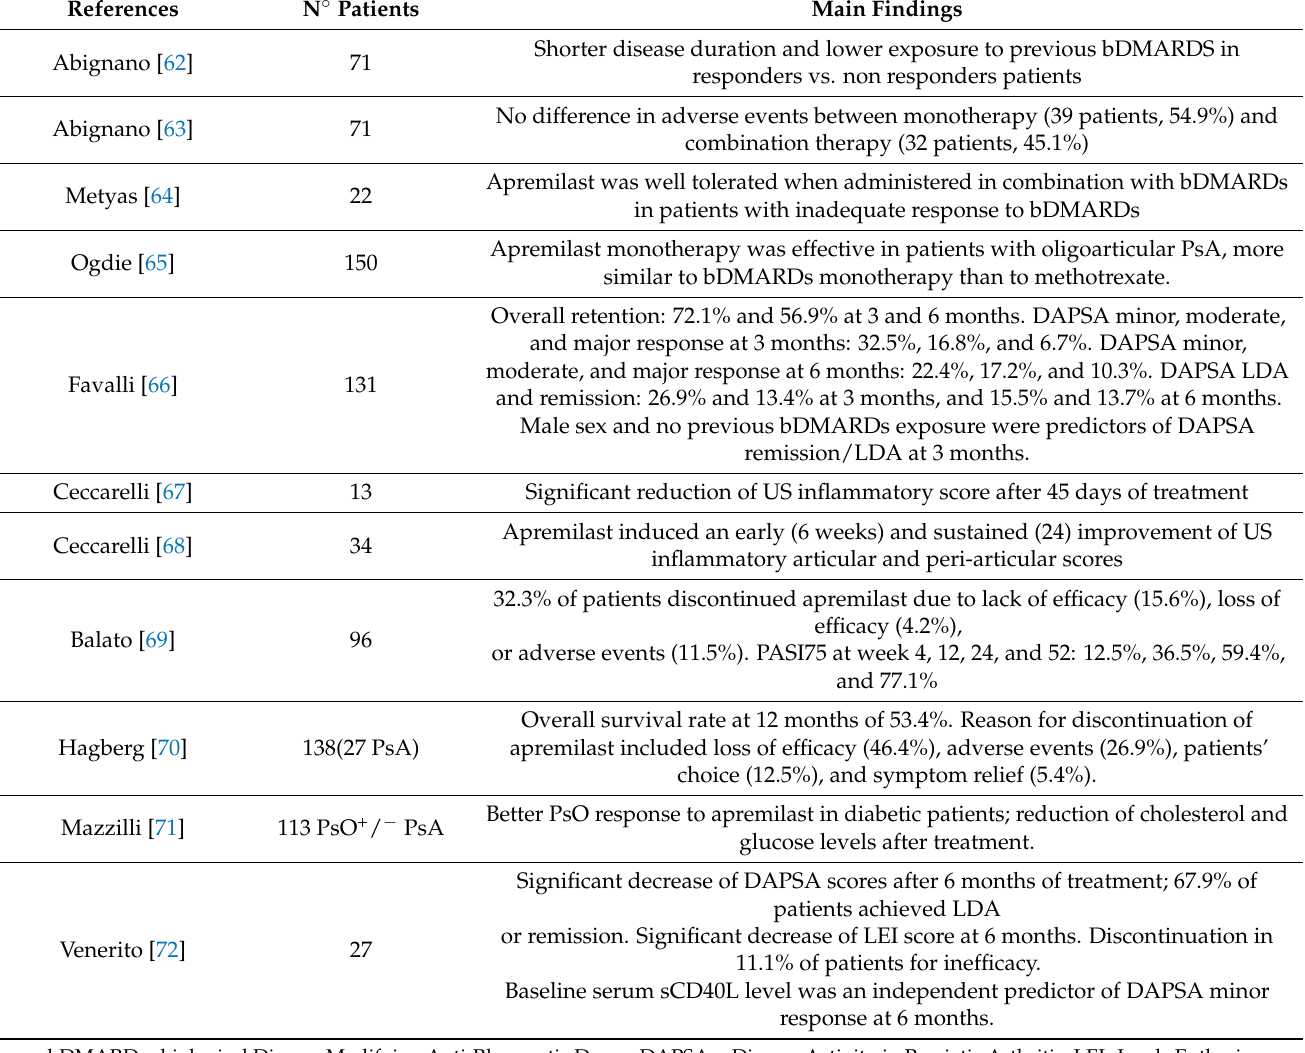
Table 1. Real-world efficacy data on apremilast in patients with Psoriatic